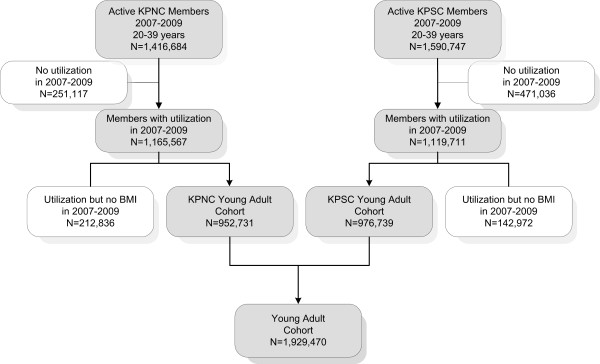
Flow chart of the Kaiser Permanente California young adult cohort.